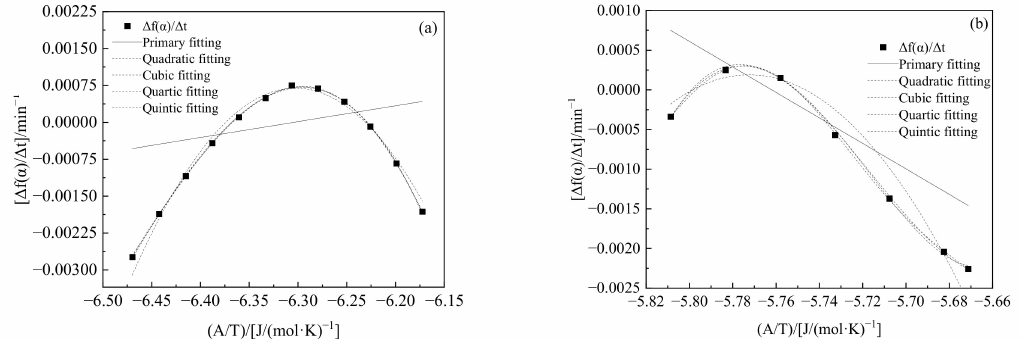
Figure 5. Fitting curves of different orders of high-order polynomials. ( a ) Fitting curve of different orders of high-order polynomials in experimental scheme 1-3; ( b ) fitting curve of different orders of high-order polynomials in experimental scheme